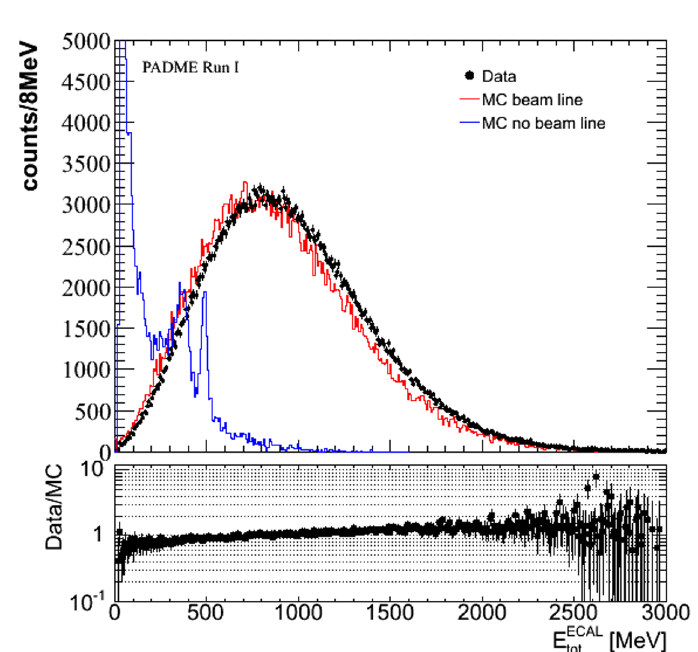
Figure 7 . Total cluster energy distribution during Run I, measured experimentally (black dots), compared against MC simulation without beam transportation (blue line), and including beam transportation (red line). The bottom plot represents the ratio between data and simulation with beam transportation